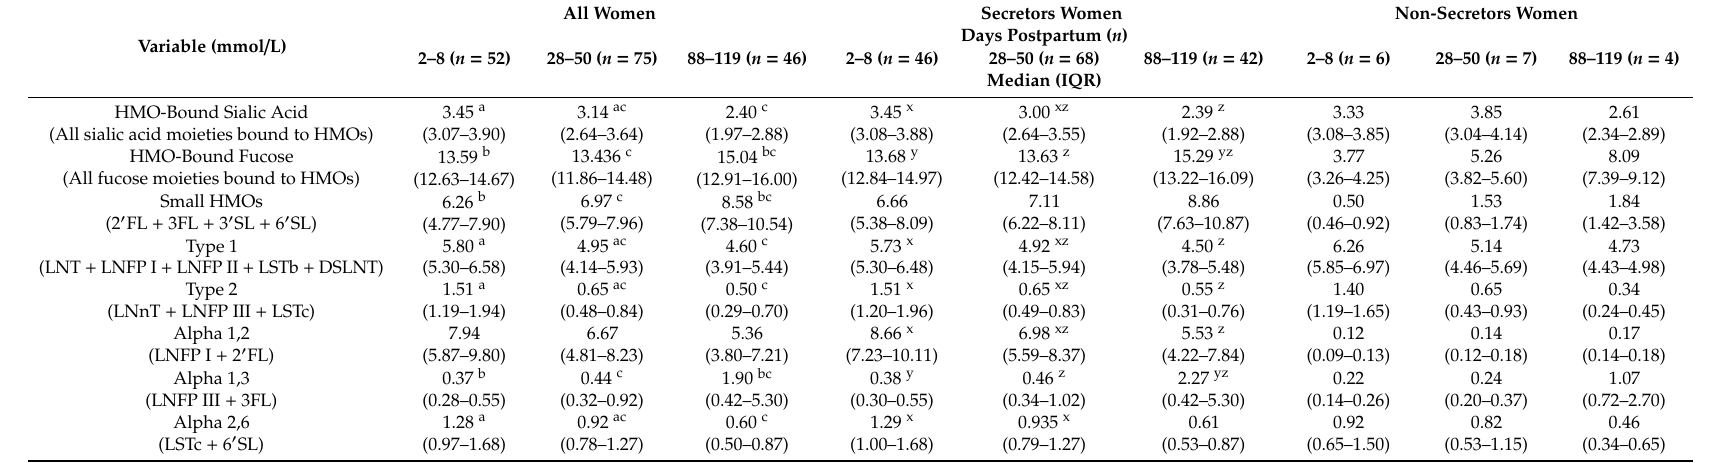
Table 3. Time variations in HMO group concentrations in women from the Brazilian cohort. Rio de Janeiro, Brazil ( n =